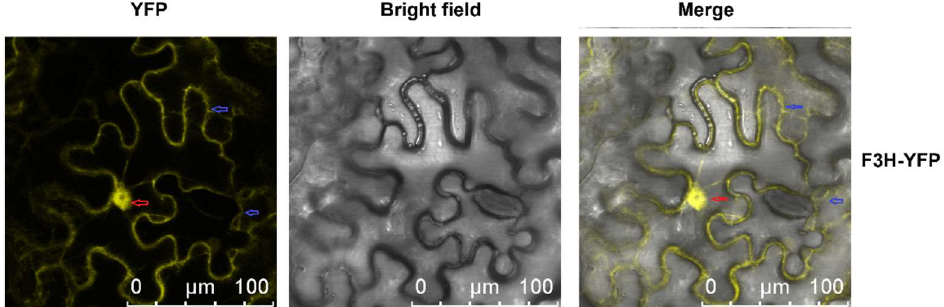
Figure 3. Subcellular location of MazsF3H . The red arrow indicates the nucleus and the blue arrow indicates the cytosol.